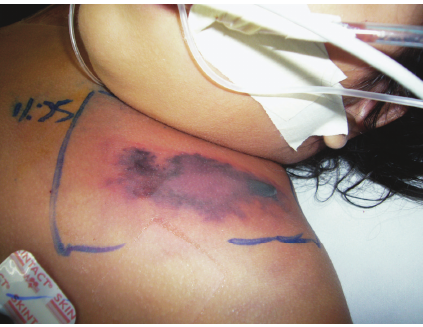
Figure 1: Left anterior chest wall 3 hours after admission in the emergency department. There is demarcated bruise and a necrotizing bullae.